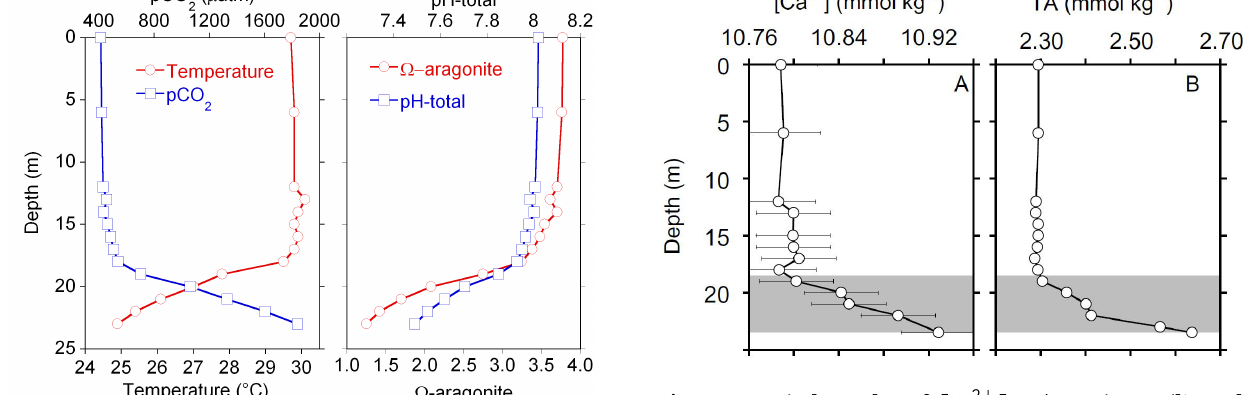
Fig. 5. Vertical profiles of [Ca 2 + ] and TA in Devil’s Hole, Bermuda. The increase of both parameters in the subthermocline layer (gray shaded area) indicates CaCO 3 dissolution from the sed- iments. Despite significant dissolution and buffering, (cid:127) -aragonite and pH remain at low levels (see Andersson et al., 2007 for detailed